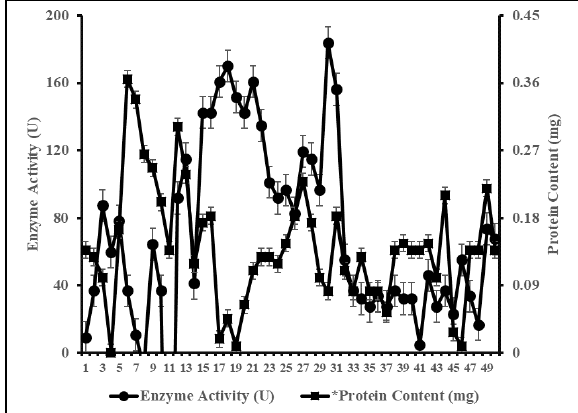
Fig. 1. The purification profile of AChE from Diodon hys- trix brain with mean of triplicates ± standard deviations